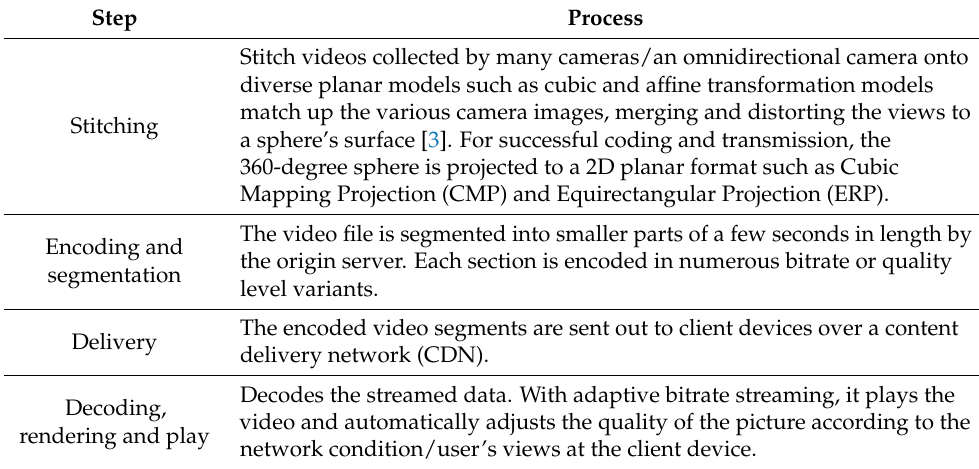
Table 2. Major steps in the DASH streaming